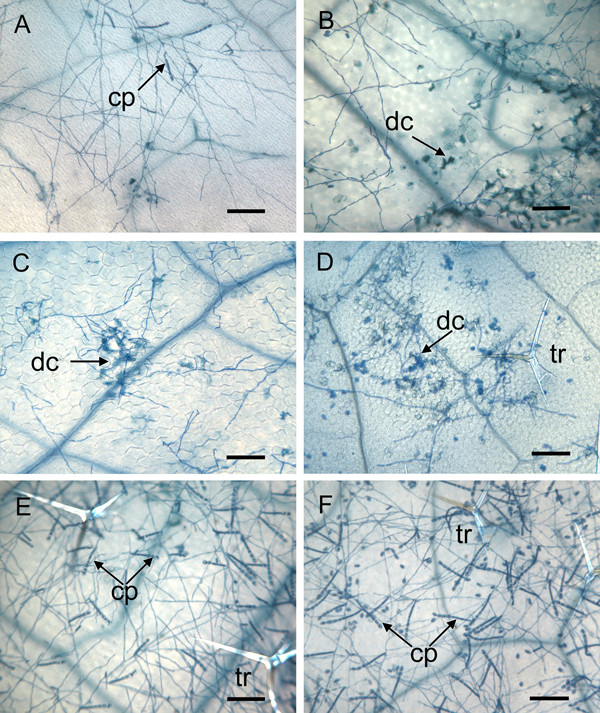
Microscopic visualization of fungal growth and cell death on leaves of 3-week-old plants at 7 dpi with G. cichoracearum. Leaves were stained with trypan blue. (A) wild type, (B) edr2-6, (C) edr2-6 coi1-1, (D) edr2-6 ein2-1, (E) edr2-6 NahG, (F) edr2-6 pad4-1. cp, conidiophores bearing asexual conidia; dc, dead cells; tr, trichome. Bar = 22 μm (A, B, D, F), 40 μm (C) and 26 μm (E).